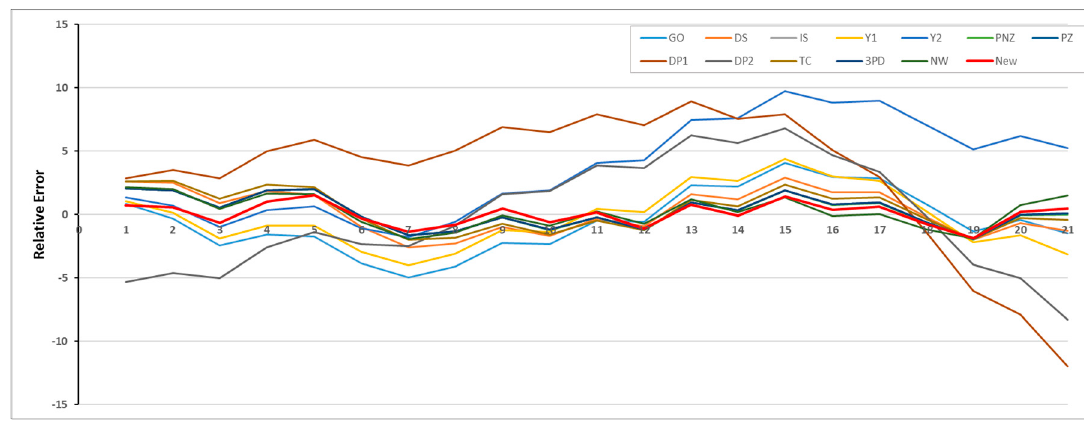
Figure 9. RE curve for Dataset #2.